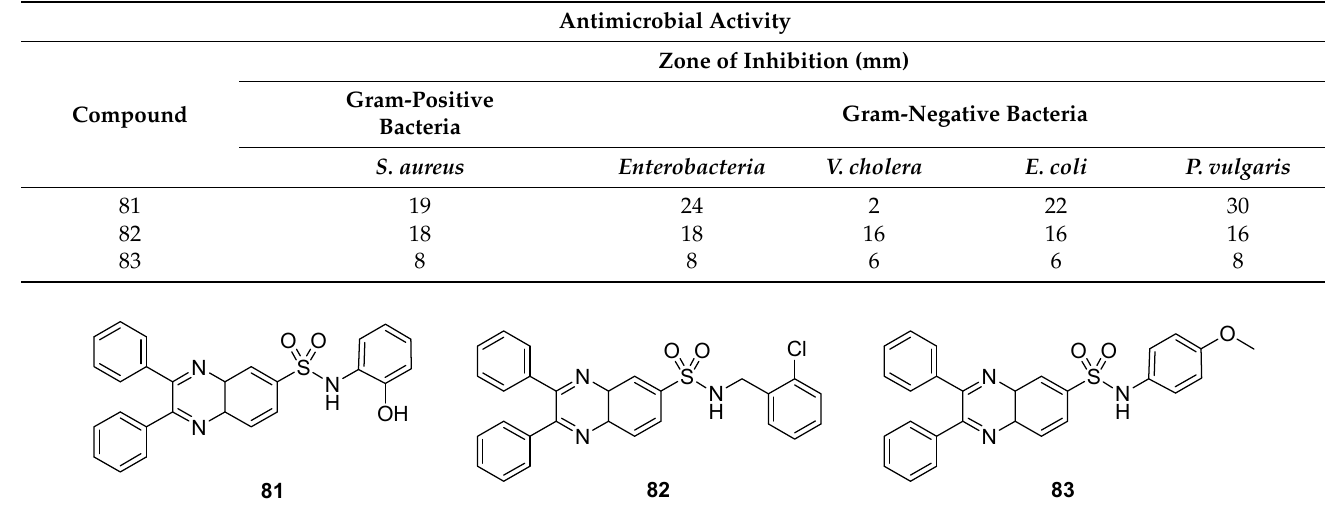
Table 6. Antimicrobial activity of quinoxaline derivatives 81 – 83 .